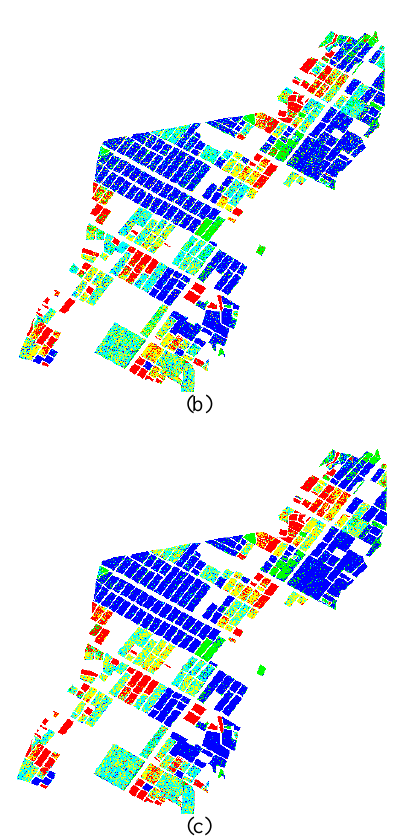
Figure 5. Contrast of three classifiers, (a) SVM classifier, accuracy is 97.49%, kappa is 0.9641. (b) BPNN classifier, accuracy is 70.12%, kappa is 0.5887. (c) Wishart classifier, accuracy is 74.85%.